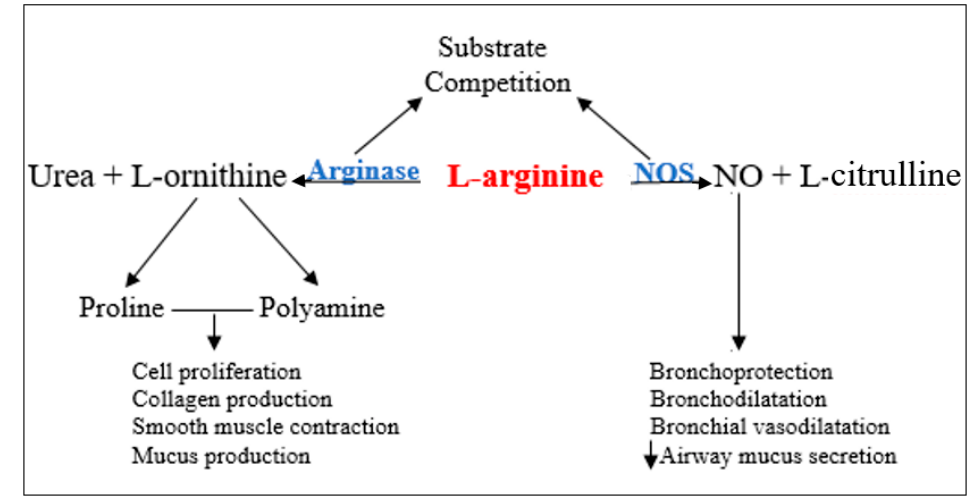
Figure 1. Nitric oxide (NO) pathway. NOS—nitric oxide synthase.